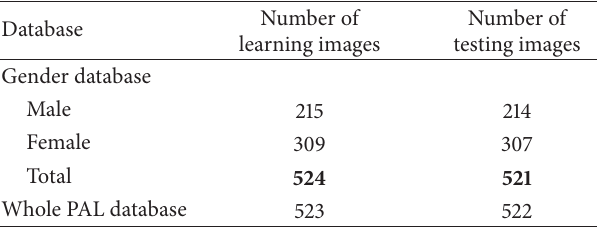
Table 7: Comparison of MAEs with and without the preclassifica- tion of gender (unit: years